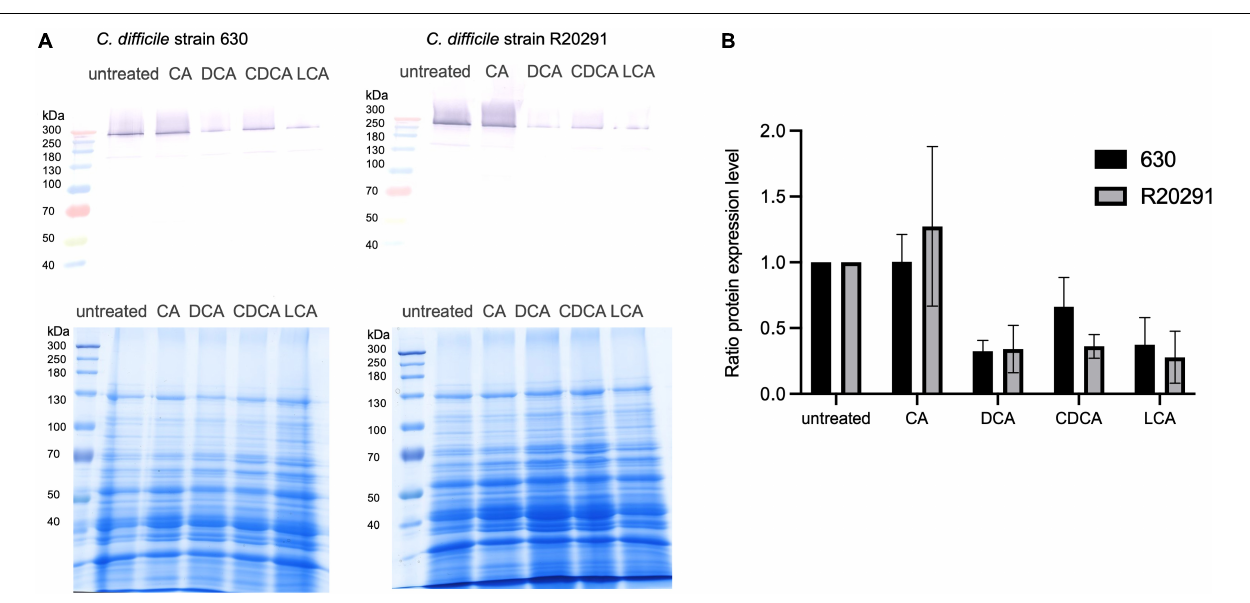
Frontiers in Microbiology |